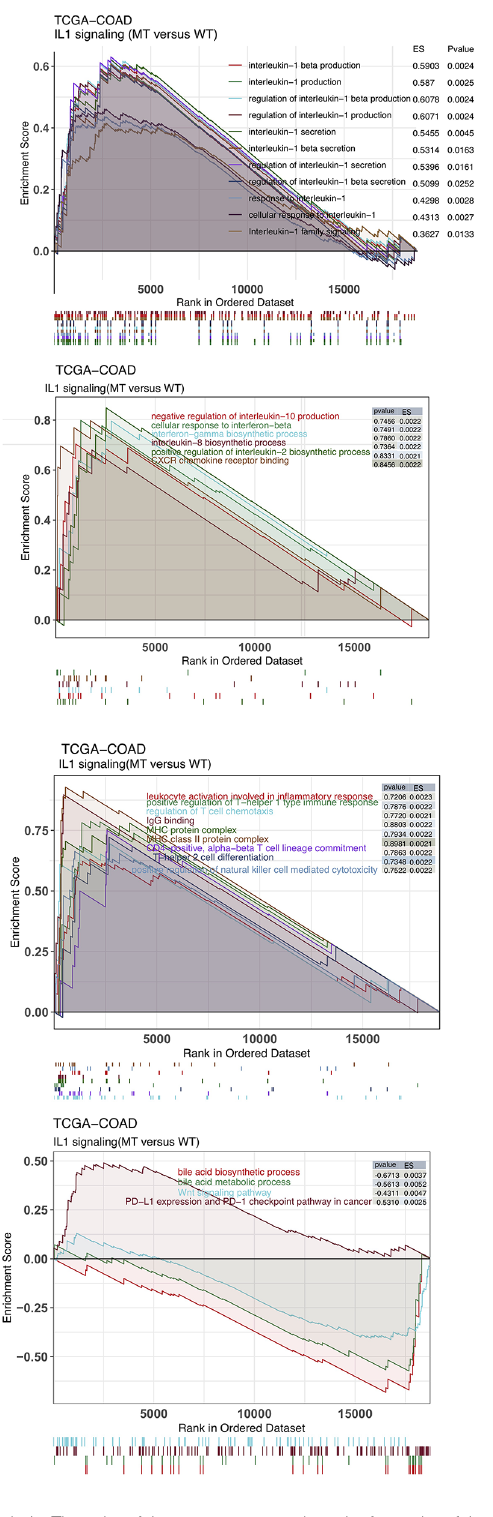
FIGURE 5 | The results of gene set enrichment analysis. The color of the curve corresponds to the font color of the pathway. GSEA of hallmark gene sets downloaded from the Molecular Signatures Database (MSigDB). Each run was performed with 1000 permutations. Enrichment results with signi fi cant differences (P < 0.05) between IL-1-MT and IL-1-WT tumors are